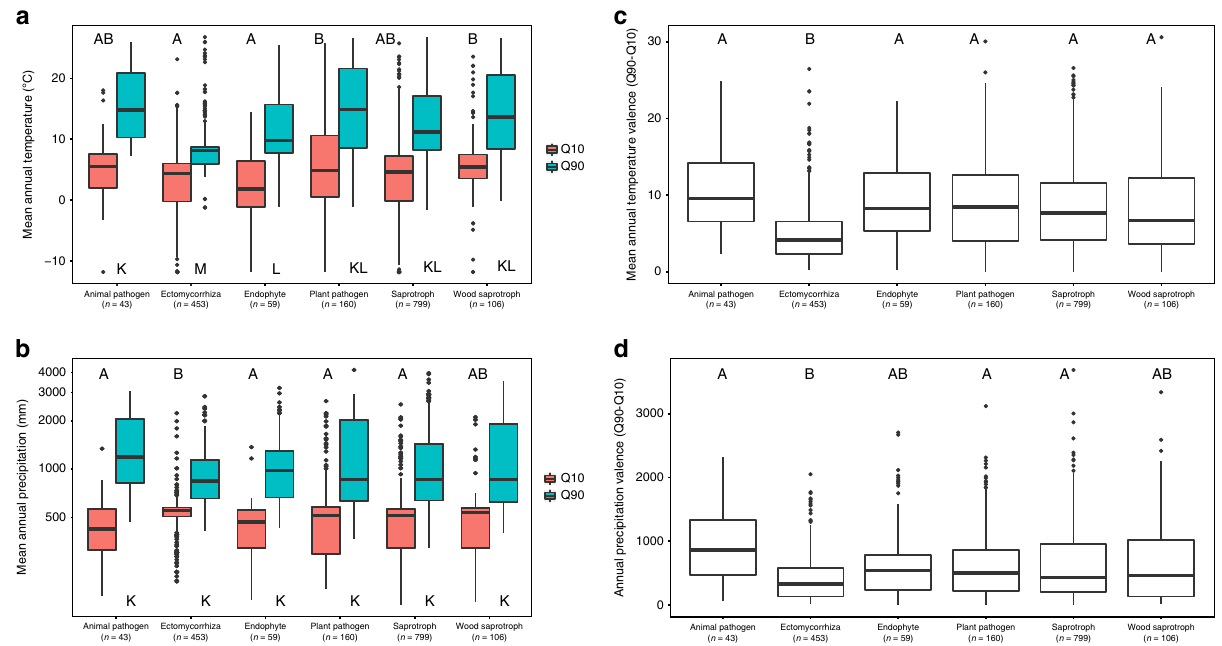
Fig. 3 Climatic determinants of ecological guilds of fungi. a The fi rst and ninth deciles of sample mean annual temperature and b annual precipitation for SHs belonging to selected ecological guilds with occurrence in >10 samples. c Ecological variance of mean annual temperature and d annual precipitation of these SHs expressed as the difference between the ninth and tenth deciles. The boxes marked with different letters are signi fi cantly different at the p < 0.05 according to Kruskal – Wallis with post hoc Nemenyi tests. In boxplots, middle line represents median, upper and bottom horizontal lines represent third and fi rst quartile, whiskers represent maximum and minimum values below the upper and lower fence and points represent